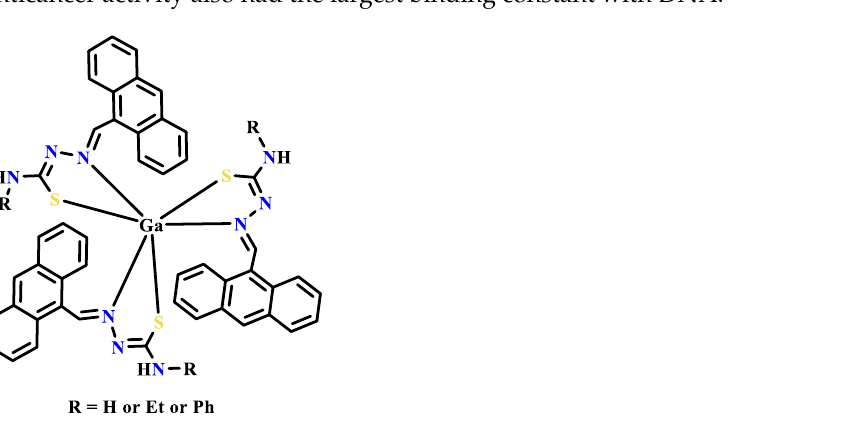
Figure 42. Three gallium(III) complexes of anthrahydrazone with ( N -ethyl/phenyl)thiourea as a side chain.